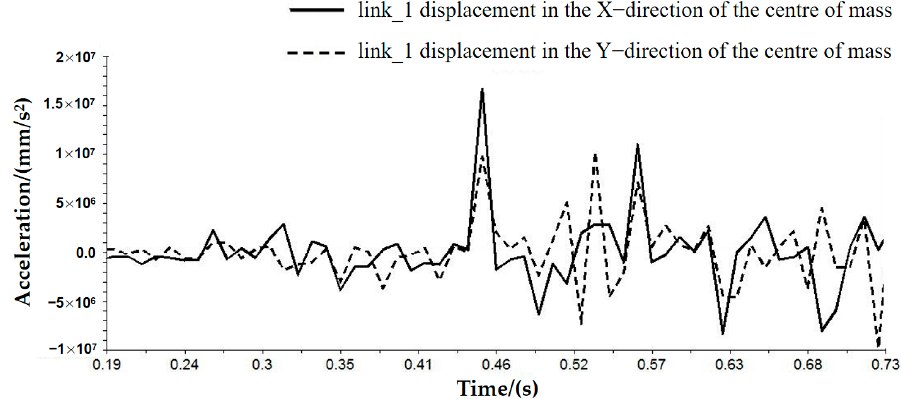
Figure 13. Acceleration of link_1.